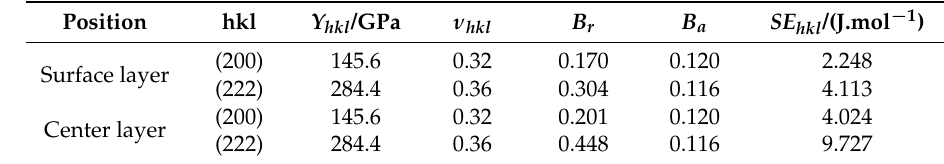
Table 2. Orientation-dependent stored energies by XRD and relevant parameters [16–18] used for stored energy calculation.